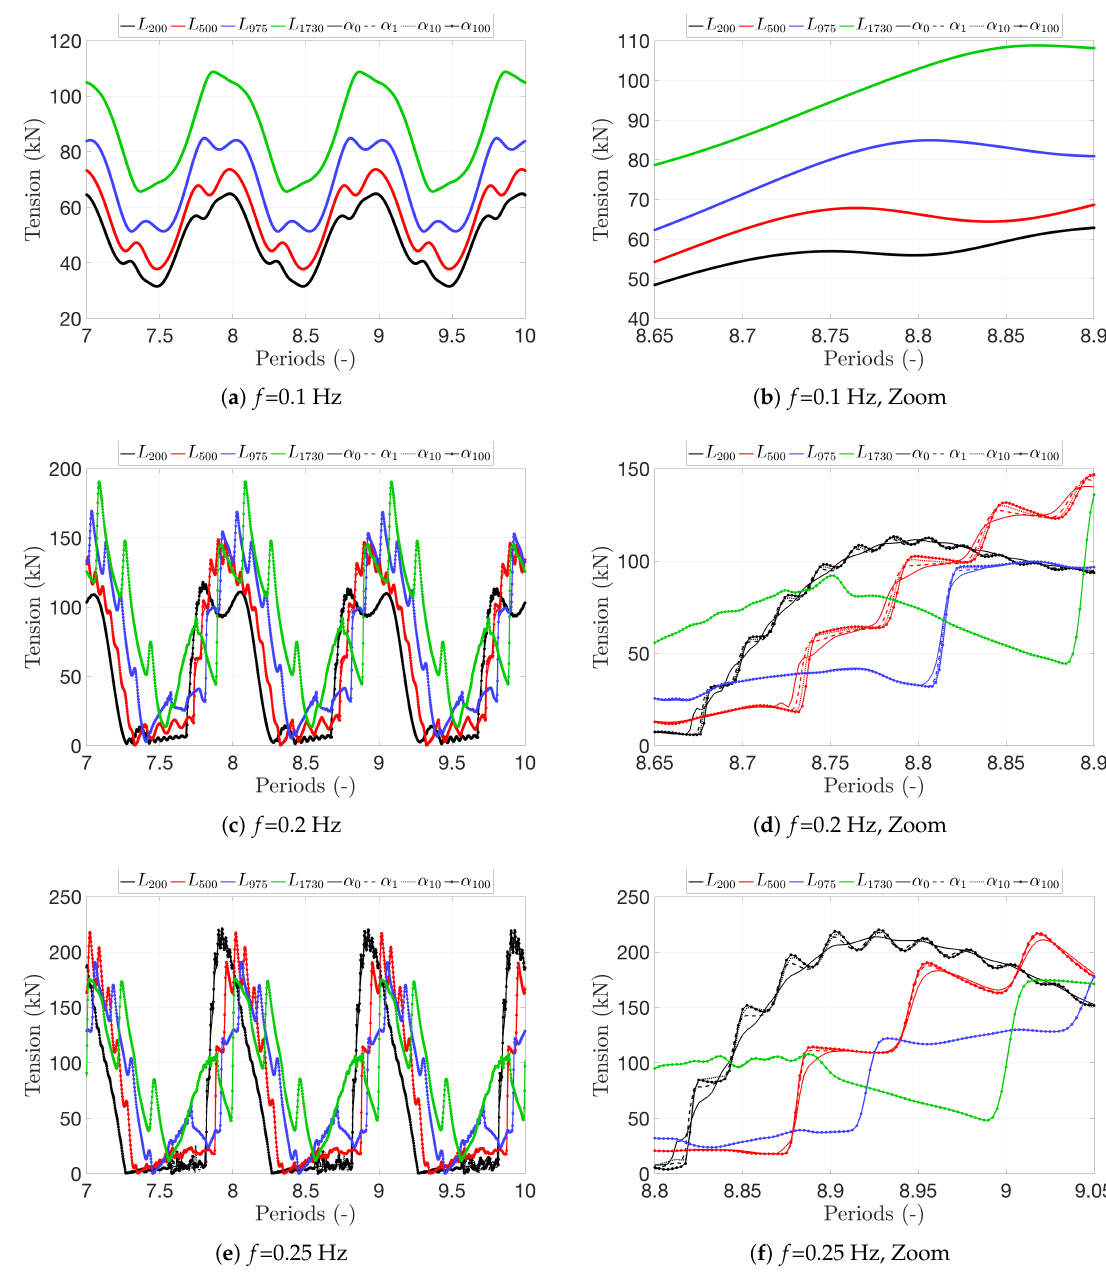
Figure 5. Tension results at the ship for different cable lengths L and bending stiffness factors α . Each colour represents a different depth, and each line-style represents a different bending stiffness factor. The line-styles are denoted with grey colour in the legends. Fairlead excitation a = 2 m amplitude circular motion of frequency: ( a , b ) f = 0.1 Hz, ( c , d ) f = 0.2 Hz and ( e , f ) f = 0.25